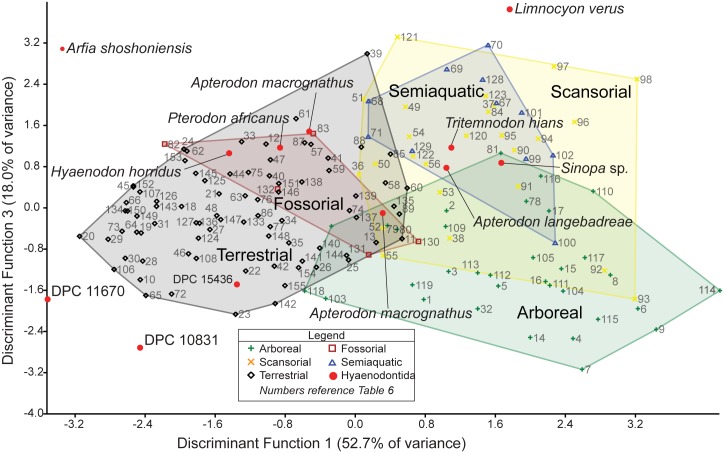
Locomotor categorization of hyaenodont humeri on DF1 and DF3.The results of discriminant function analysis for DF1 (explains 52.7% of variance) plotted against DF3 (explains 18.0% of variance). The analysis is based on 20 linear measurements (see Fig 2) collected for 155 carnivoran specimens (55 species) and 12 hyaenodont specimens (8 species). Numbers correspond to specimen numbers in Table 5, S4 and S5 Tables. Refer to Table 6 for classification of the hyaenodontan sample. Refer to Table 7 for measurements loadings. Each point represents a specimen, not a species mean. Green plus, Arboreal carnivoran specimens; Yellow X, Scansorial carnivoran specimens; Black diamond, Terrestrial carnivoran specimens; Red squares, Fossorial carnivoran specimens; Blue triangles, Semiaquatic carnivoran specimens; Red dots, hyaenodontans with unassigned locomotor behaviors.